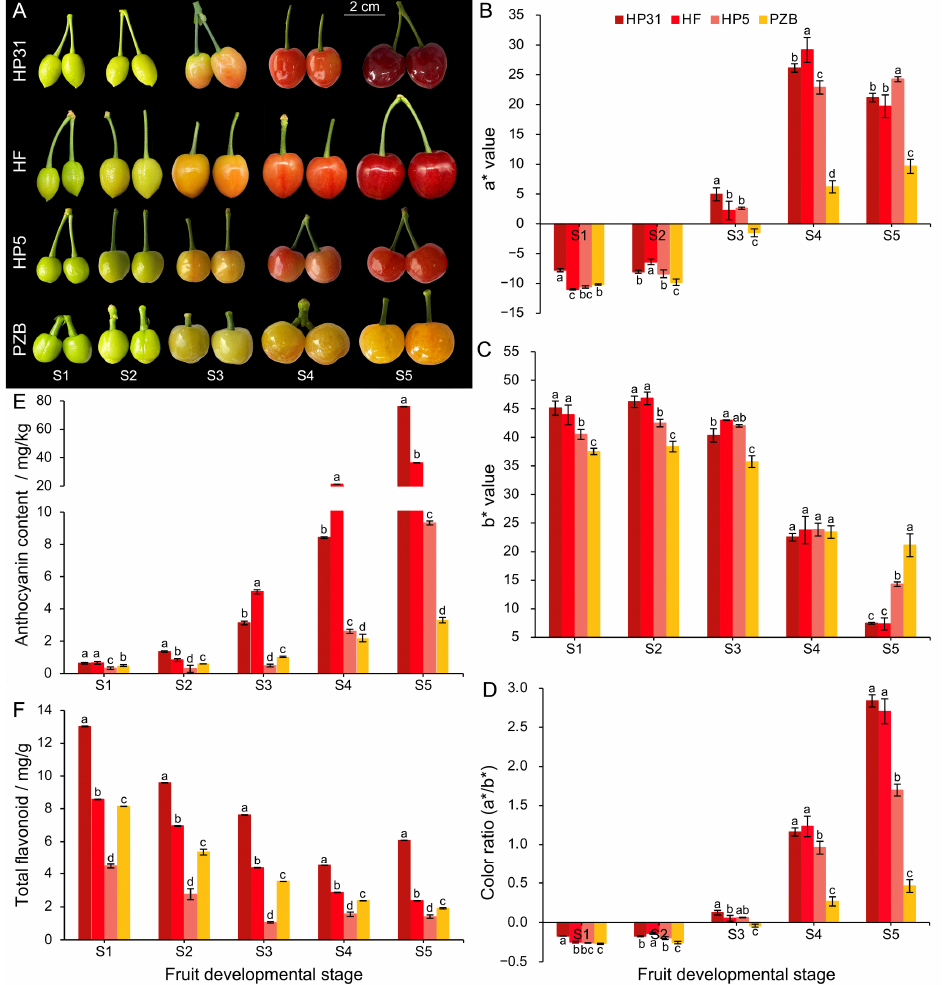
Figure 1. Color phenotypic characterization of Chinese cherry during fruit development. ( A ) Fruit phenotypes during development in dark-red and yellow fruits. ( B ) The a* values. ( C ) The b* values. ( D ) Color ratio (a*/b*). The a* coordinate represents the red (positive)-to-green (negative) scale, the b* coordinate represents the yellow (positive)-to-blue (negative) scale. Color ratio (a*/b*) represents the comprehensive color index [32]. ( E ) Total anthocyanin content. ( F ) Total flavonoids content. Error bars indicate ± standard deviation (SD) from three independent biological replicates. The lower case letters indicate significant difference at 0.05 level.